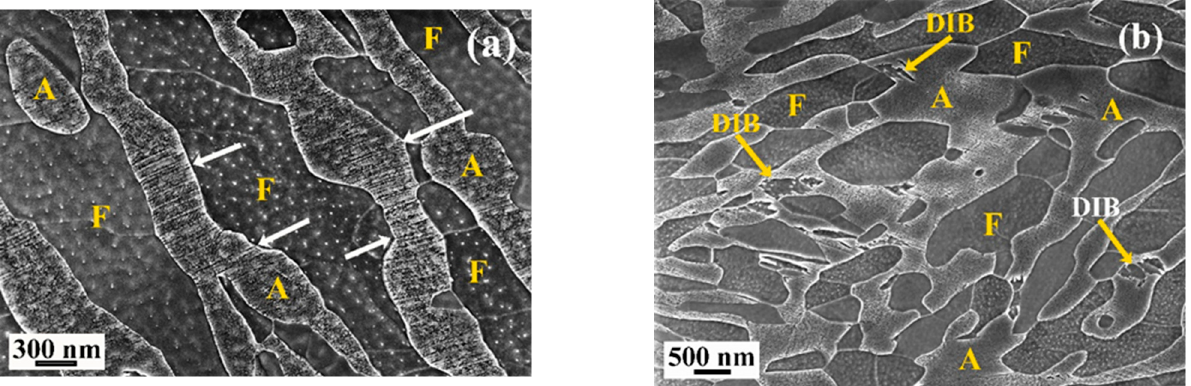
Figure 11. ( a ) SEM micrograph showing high density of twin traces, marked by white arrows, in austenite grains after being tested at 225 °C to an elongation of 30%. ( b ) SEM micrograph showing only a small amount of DIBs in a specimen tested at 225 °C to fracture. F: ferrite, A: austenite.